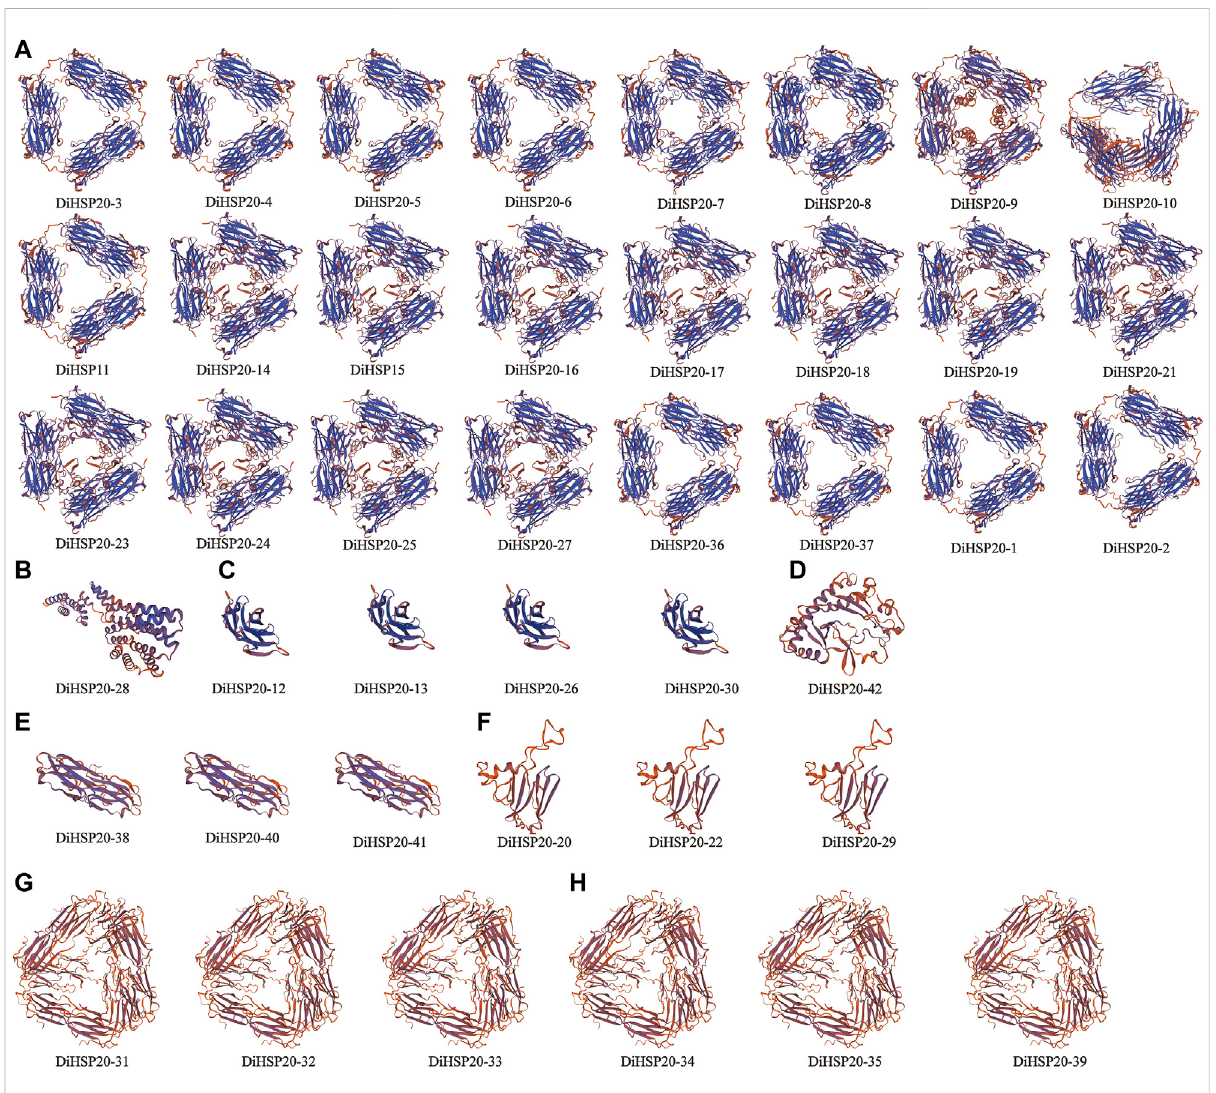
FIGURE 3 The anticipated 3-dimensional structural models of DiHSP20 proteins are depicted in cartoon form. The distinct categories are represented by capital letters (A – H)